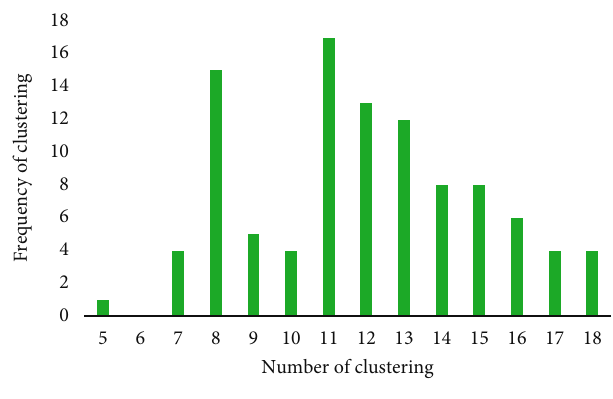
Figure 3: Frequency of clustering